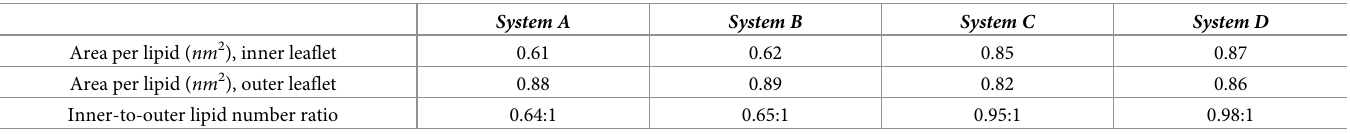
Table 1. Differences in the equilibrium configuration properties between the NPSLBL and the